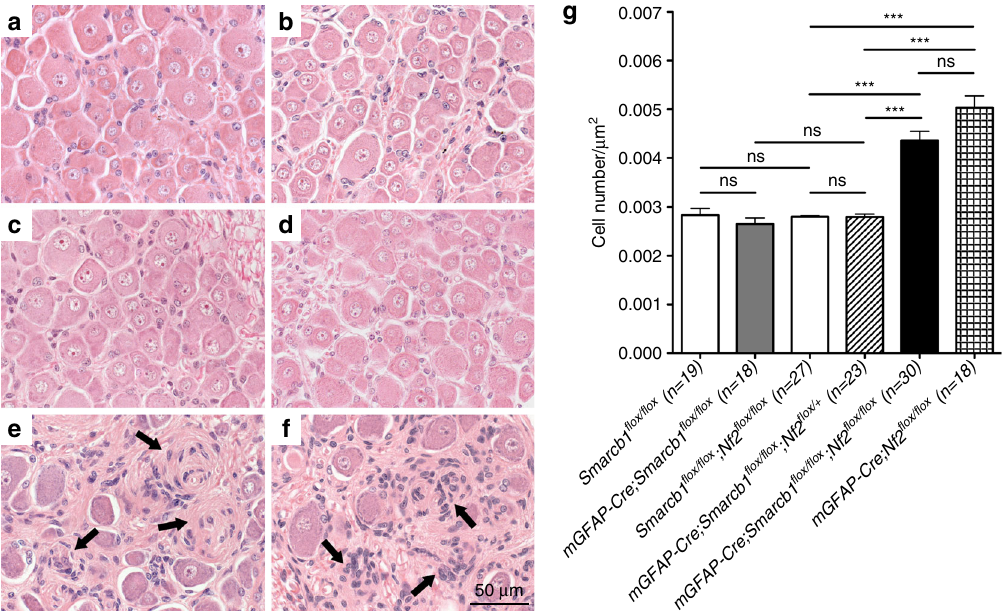
Fig. 5 Biallelic loss of Nf2 is necessary to induce schwannoma formation. a , b No difference in cellularity of DRGs from mGFAP-Cre;Smarcb1 fl ox/ fl ox mice ( b ) compared with Smarcb1 fl ox/ fl ox control mice ( a ). c – f The loss of one additional Nf2 allele in mGFAP-Cre;Smarcb1 fl ox/ fl ox ;Nf2 fl ox/ + mice does not impair the DRG cellularity ( d ) compared to mGFAP-Cre;Smarcb1 fl ox/ fl ox mice ( b ) or Smarcb1 fl ox/ fl ox ;Nf2 fl ox/ fl ox control mice ( c ). The biallelic loss Nf2 induced the formation of schwannoma tumorlets in mGFAP-Cre;Smarcb1 fl ox/ fl ox ;Nf2 fl ox/ fl ox mice ( e ), similar to mGFAP-Cre;Nf2 fl ox/ fl ox mice ( f ). g Number of cells per DRG surface for each genotype. Data are represented as mean ± s.e.m.; n is the number of DRG analyzed per genotype, ns (not signi fi cant), ***( P < 0.001), two-tailed